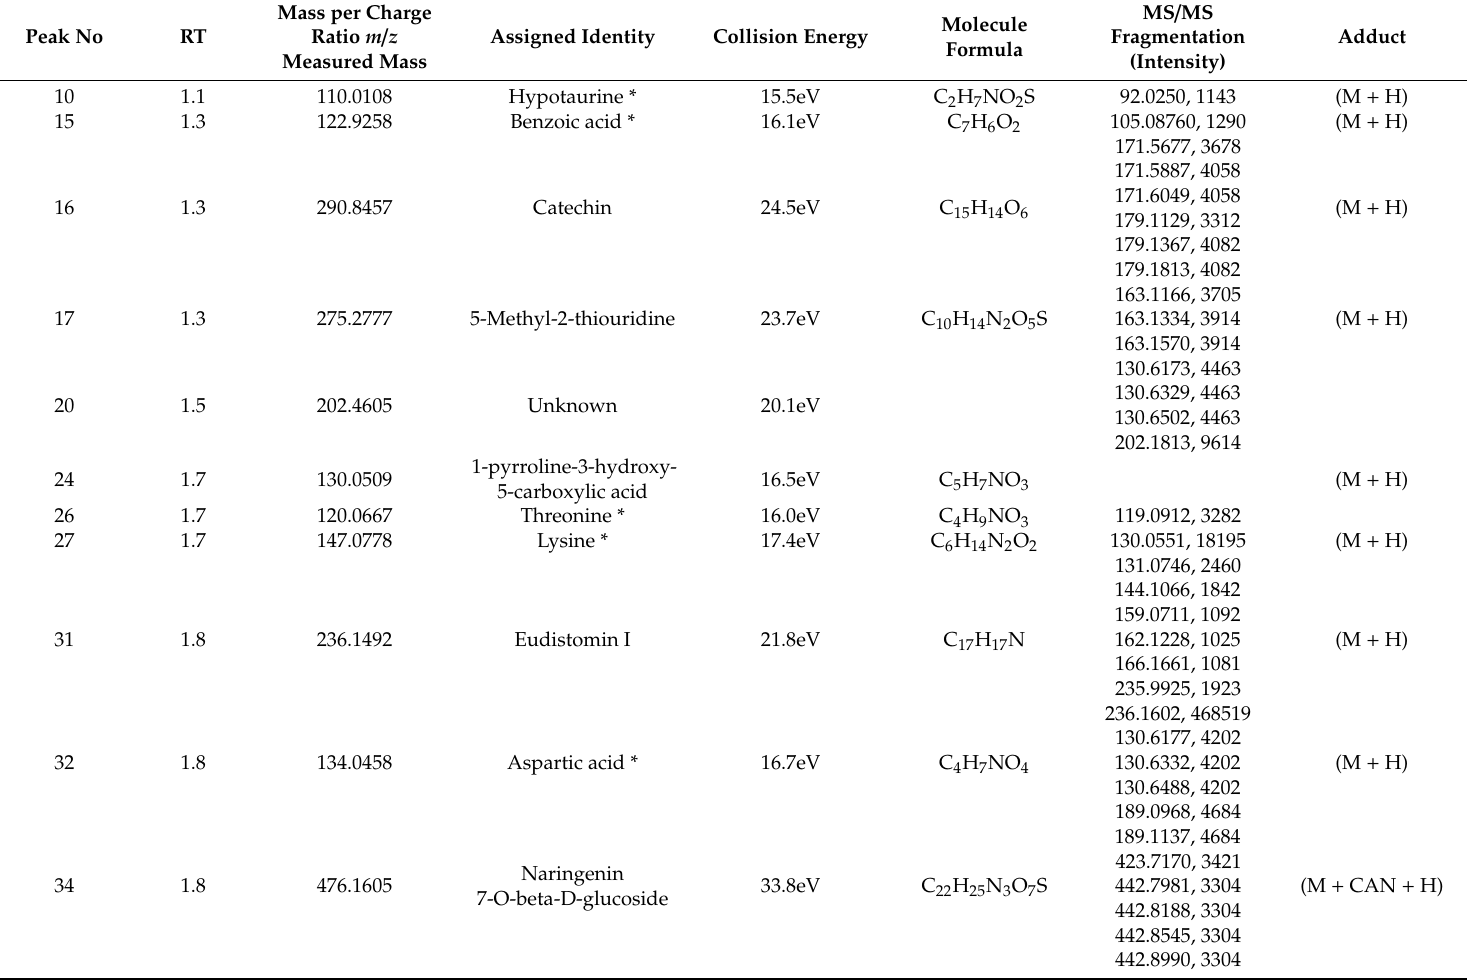
Table 3. Metabolites that were detected in G0 R3